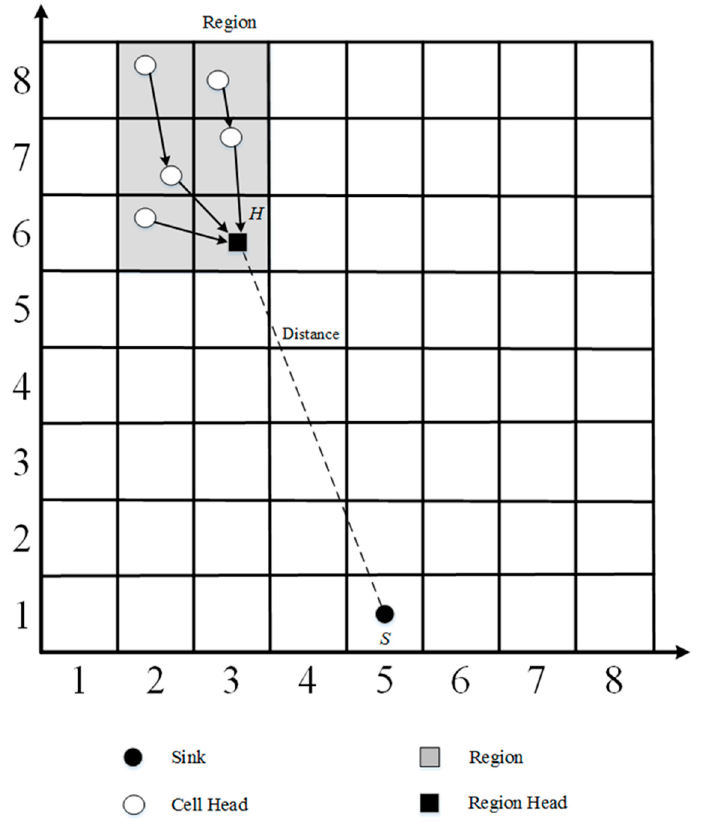
Figure 2. Region head election.